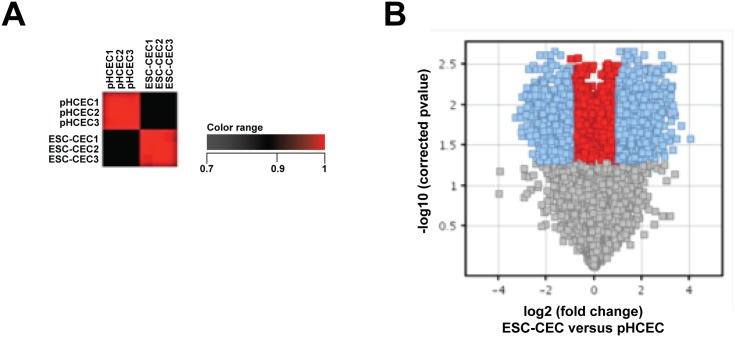
Microarray analysis indicates hESC-CEC were highly similar to primary cultured adult HCECs.A. Correlation analysis. Red color indicated little global variability between samples within group of human corneal endothelial cells (pHCECs) and human embryonic stem cell derived corneal endothelial cells (ESC-CEC). B. Volcano plot indicated most genes expressed by pHCECs and ESC-CEC were within 2 fold.